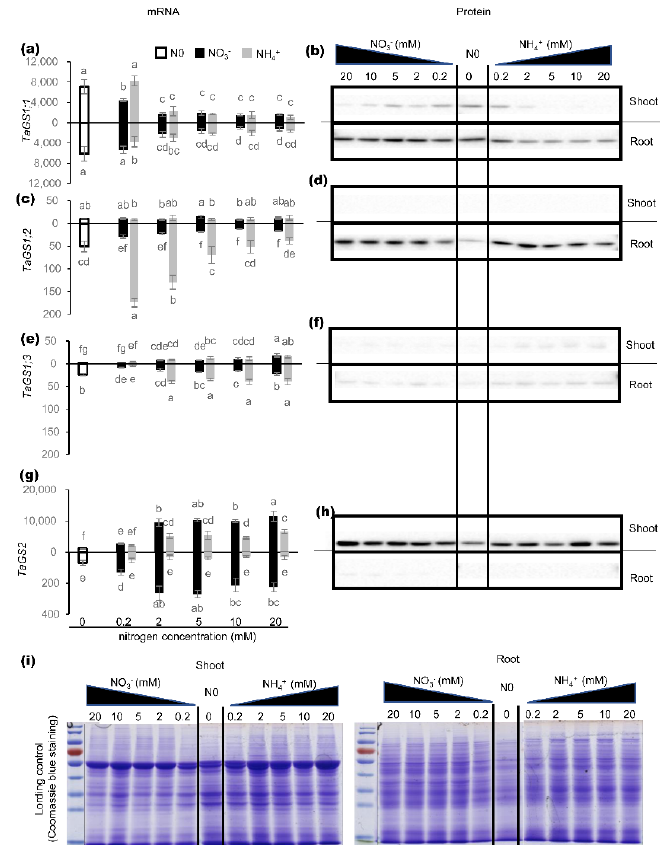
Figure 1. Expression patterns of individual wheat glutamine synthetase (TaGS) isoforms at mRNA and protein level. Quantitative RT-PCR analysis of ( a ) TaGS1;1, ( c ) TaGS1;2, ( e ) TaGS1;3, and ( g ) TaGS2 gene expression in response to di ff erent nitrogen regimes in shoots and roots. Horizontal axes show millimolar concentration of NO 3 − and NH 4 + treatments, vertical axes show mean relative expression of each isoform normalized to reference genes TaATPase and TaTEF . Data are means of three independent biological replicates ± SD. Letters above samples indicate statistically significant differences where p < 0.05 according to one-way ANOVA Duncan post-hoc test. Western-blot analysis of ( b ) TaGS1;1, ( d ) TaGS1;2, ( f ) TaGS1;3, and ( h ) TaGS2 protein content in response to di ff erent nitrogen regimes in shoots and root tissue. ( i ) Coomassie blue staining indicates equal total protein